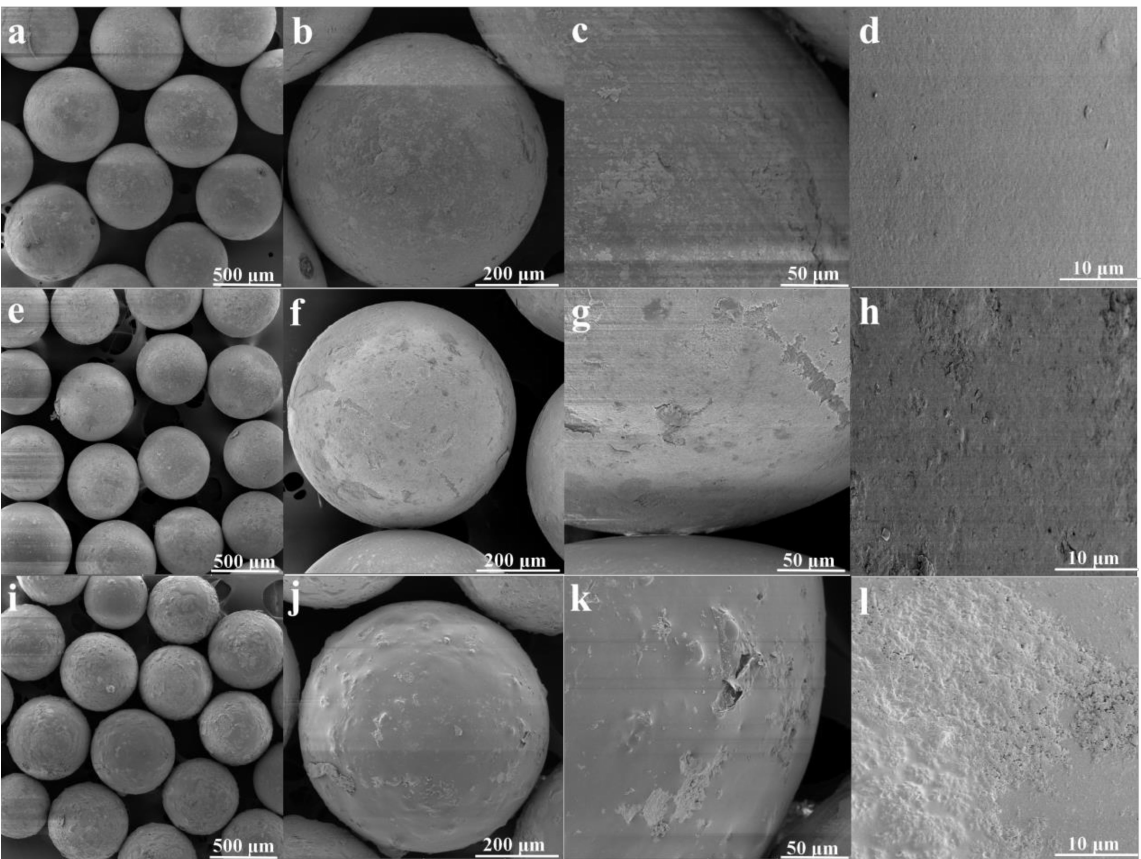
Figure 3. SEM images of ( a – d ) magnetic PMMA, ( e – h ) magnetic PMMA-PGMA and ( i – l ) magnetic